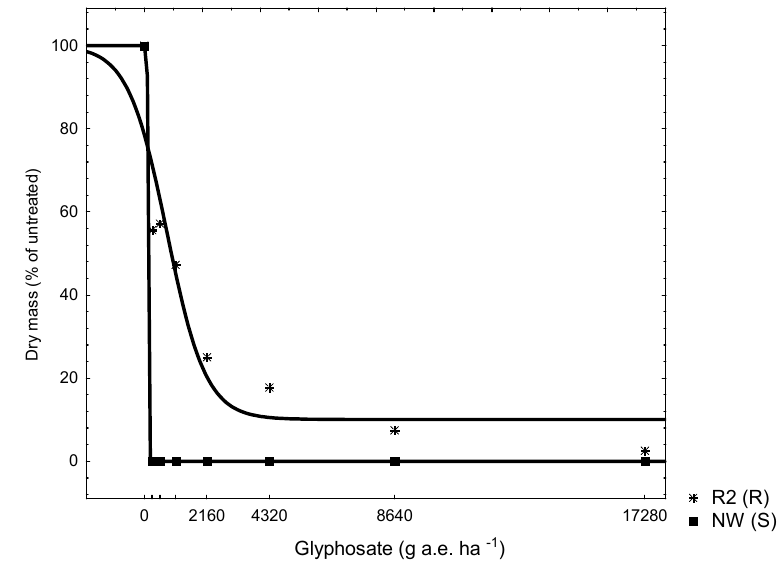
Figure 2. Dry mass of susceptible NW (S) and putative resistant R2 (R) plantago ( Plantago lanceolata L.) seedlings, 42 days after application of different glyphosate dosages rates.